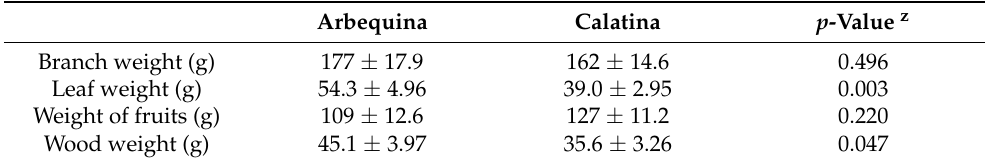
Table 1. Weight of two-year-old bearing branches and its components from ‘Arbequina’ and ‘Calatina’ olive